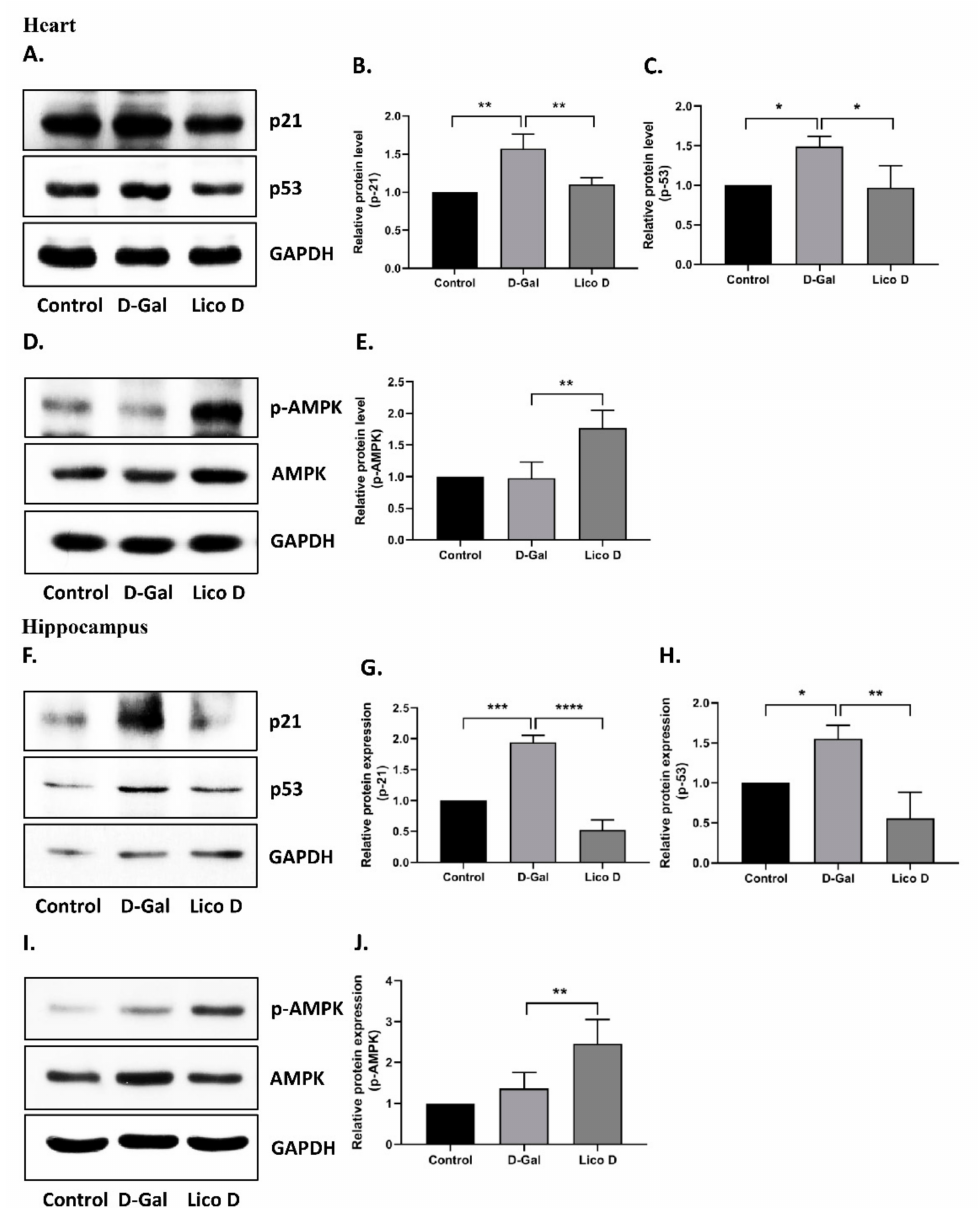
Figure 6. AMPK activation ameliorates the senescence in heart and hippocampus. Representative images from immunoblot against p53, p21 and GAPDH from heart ( A – C ) and hippocampus ( F – H ) tissues. The representative images from im- munoblot against AMPK, p-AMPK and GAPDH from heart ( D , E ) and hippocampus ( I , J ) tissues. The expression levels of proteins were quantified using Images J software. All data are represented as mean ± SD ( n = 3–4) * p < 0.05; ** p < 0.01; *** p < 0.001 and **** p <